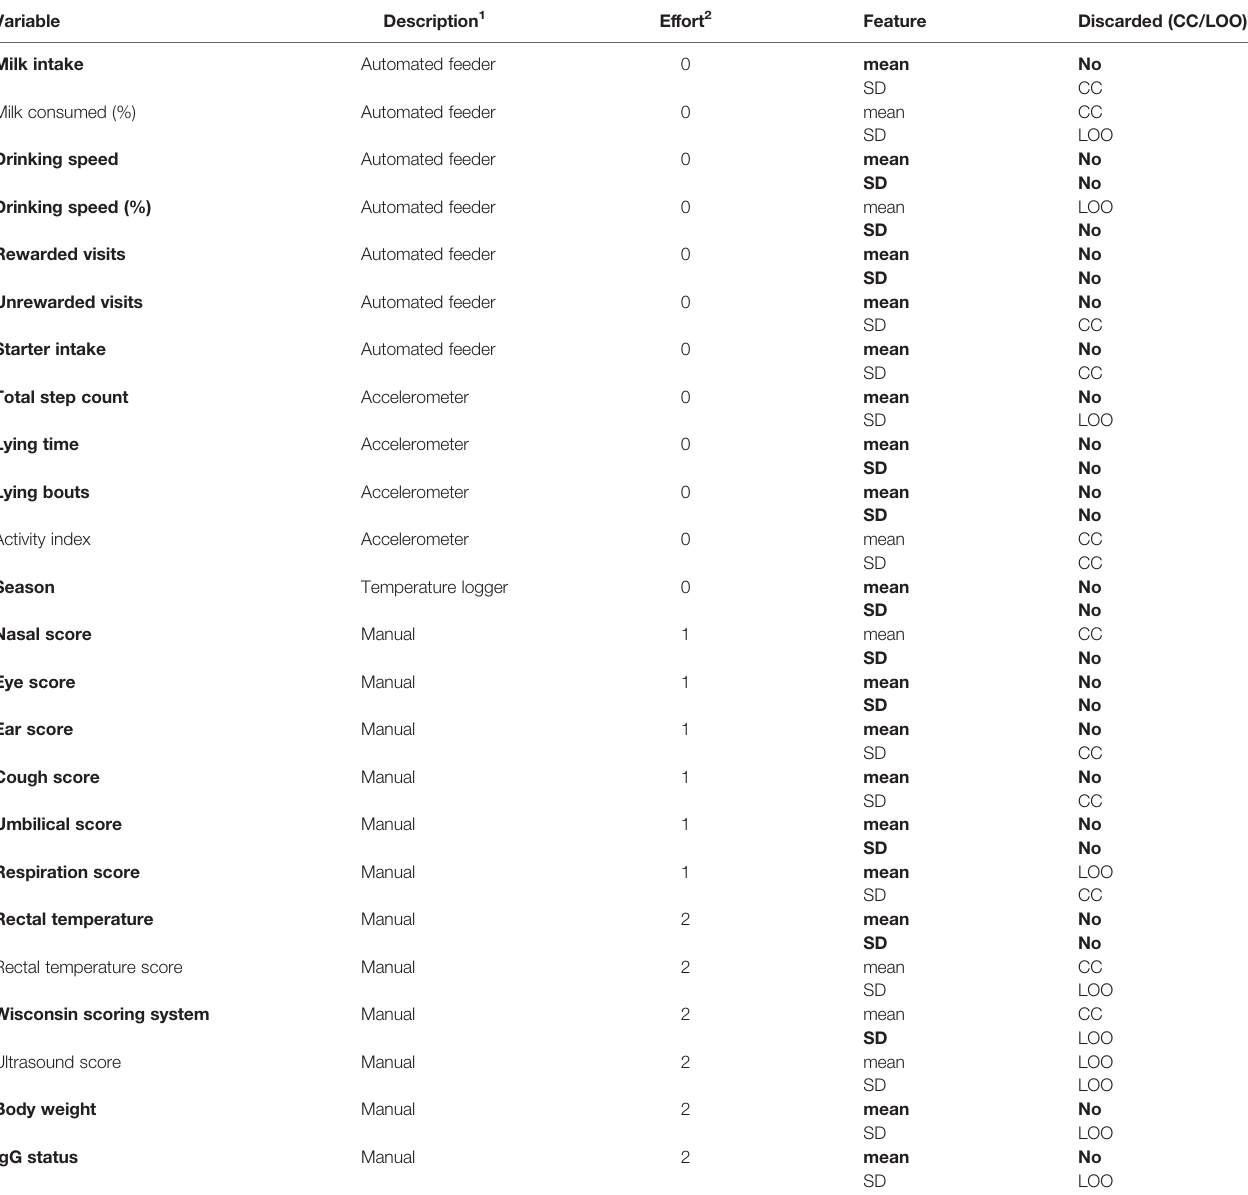
TABLE 1 | Features used by algorithm to indicate Bovine Respiratory Disease status in 106 calves.